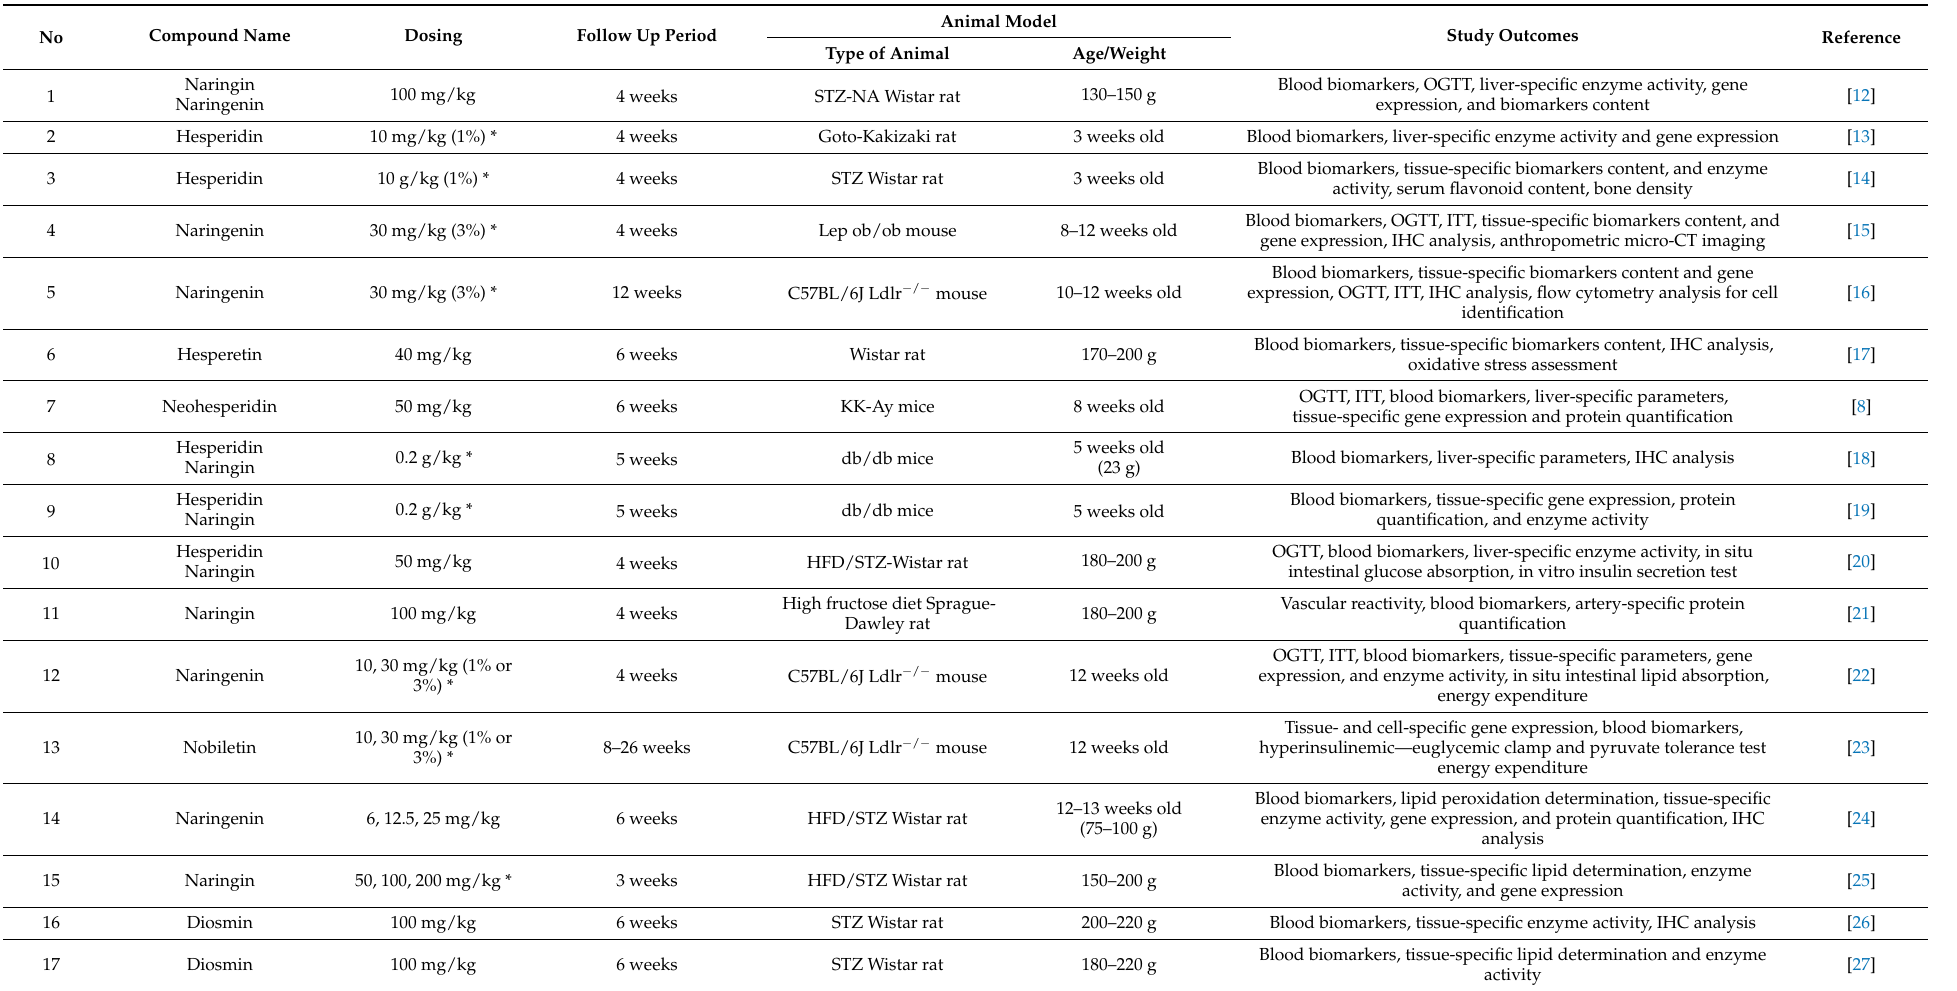
Table 1. Study design of selected articles on diabetes animal